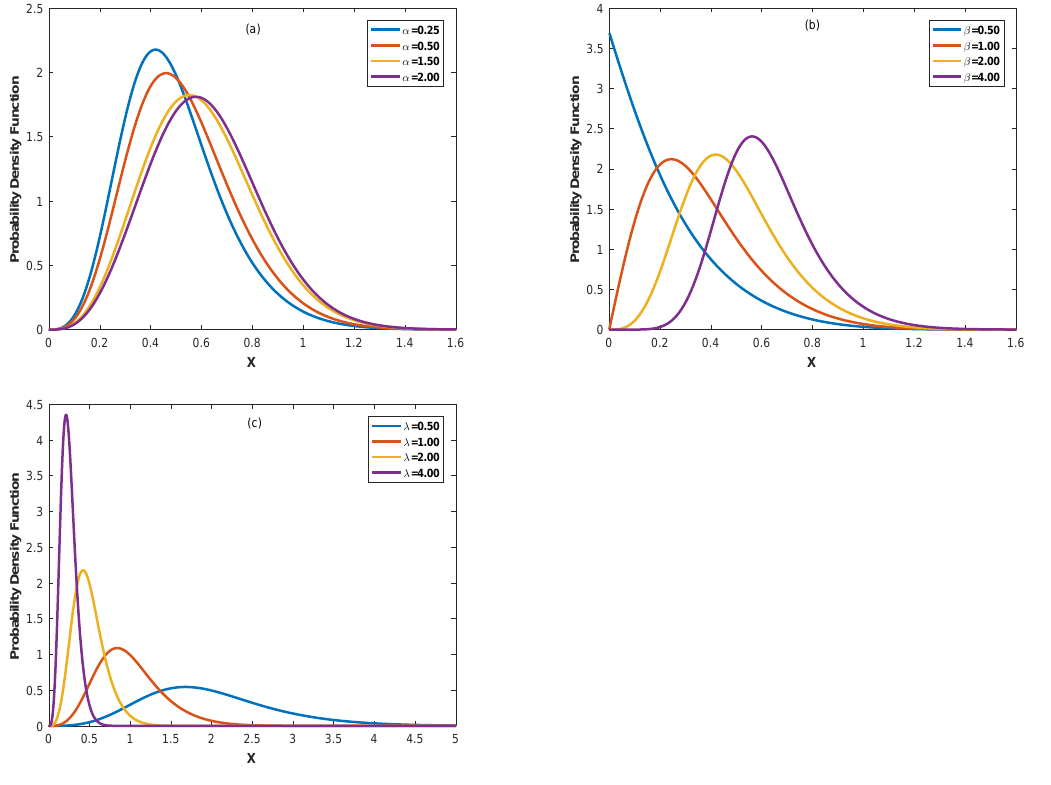
Figure 1: The pdf of the APGR distribution, when ( a ): α = 0.25, 0.5, 1.5, 2. , β = 2 and λ = 2 ; ( b ): α = 0.25 , β = 0.5, 1, 2, 4 and λ = 2 , ( c ): α = 0.25 , β = 2 and λ = 0.5, 1, 2,